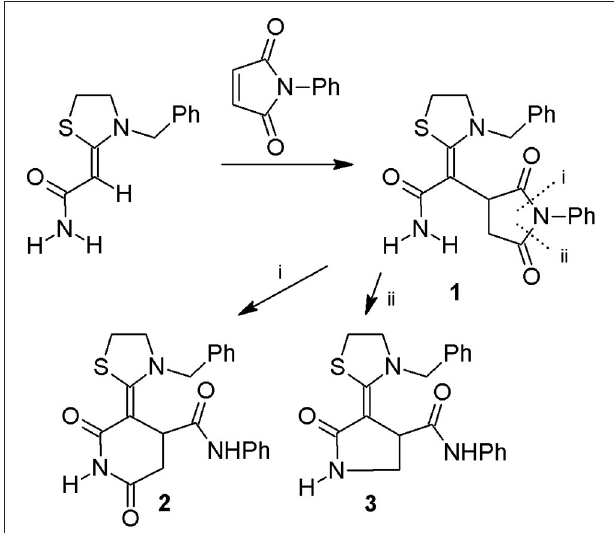
FIGURE 1 | A chemical reaction aimed at obtaining compound 1 . Ph =